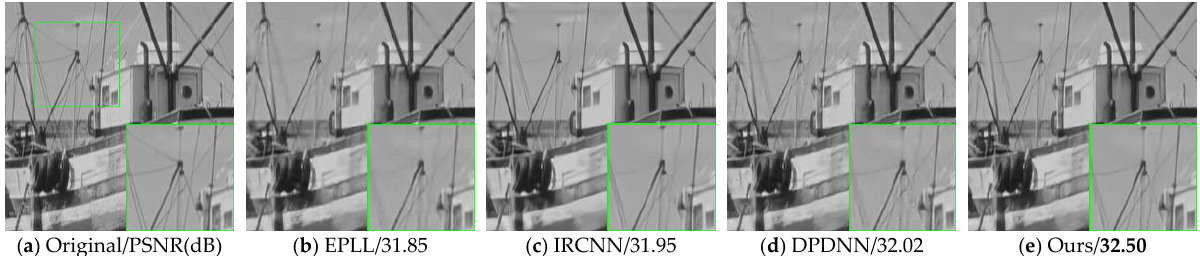
Table 6. The Average PSNR Values of The Test Methods For Deblurring on The Kodak24 Dataset. Method Gaussian Blur with Stand- ard Deviation 1.6,